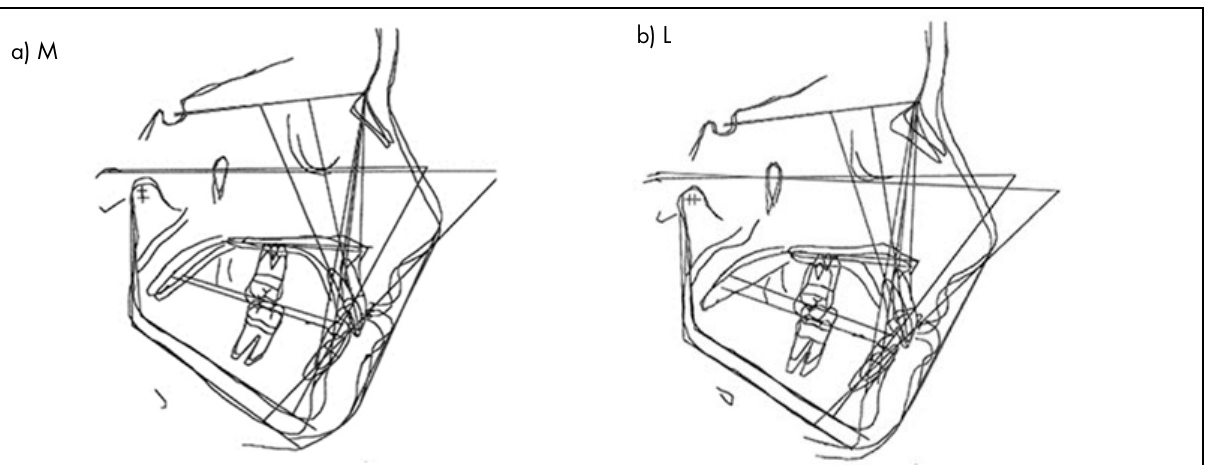
Figure 15. Cephalometric superimpositions at T1 (12Y 1M) and T2 (14Y